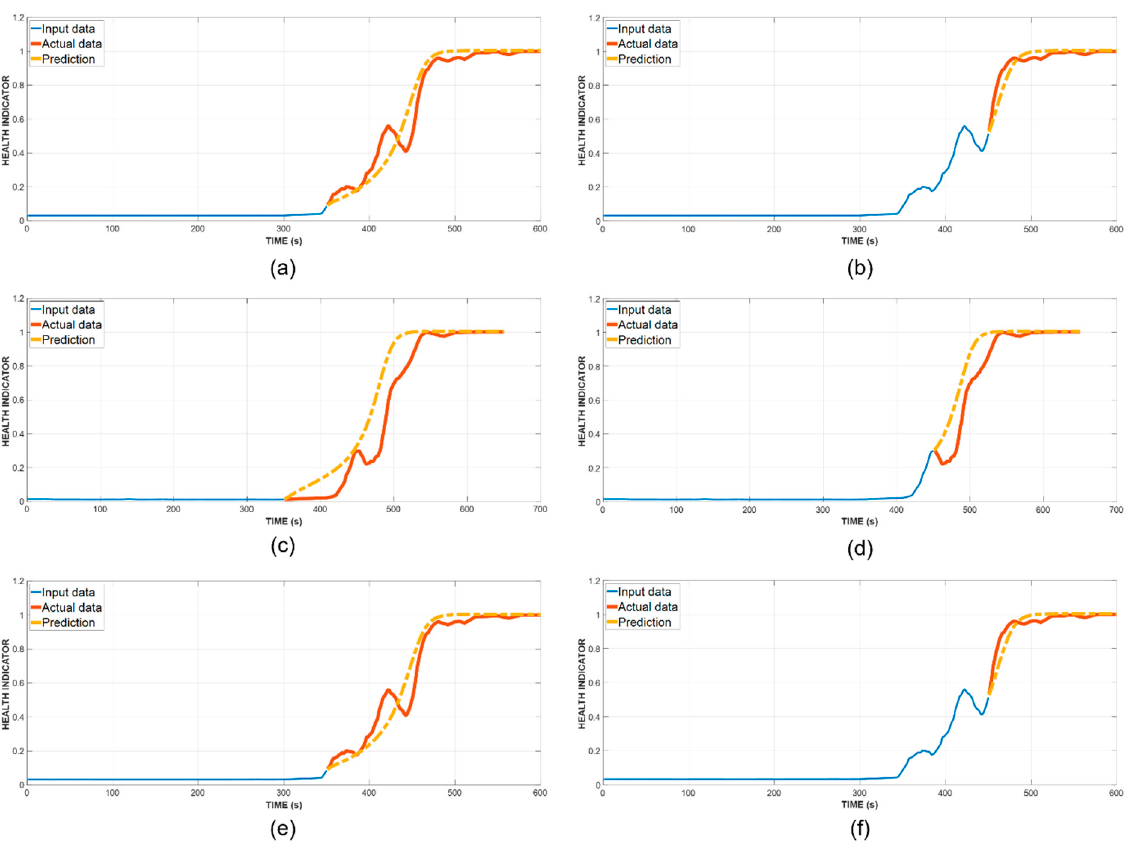
Figure 9. HI prediction results from sensor 8 at two different time steps during the three tests. ( a ) Specimen A at the 350th s. ( b ) Specimen A at the 450th s. ( c ) Specimen B at the 350th s. ( d ) Specimen B at the 450th s. ( e ) Specimen C at the 350th s. ( f ) Specimen C at the 450th s.